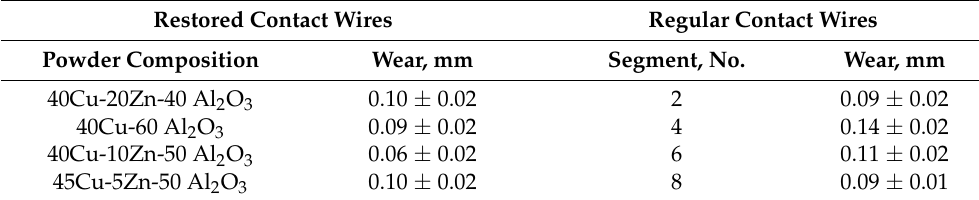
Figure 7. The dependence of adhesion on initial content of Zn and Al 2 O 3 in powder mixtures. Table 4. Wear test